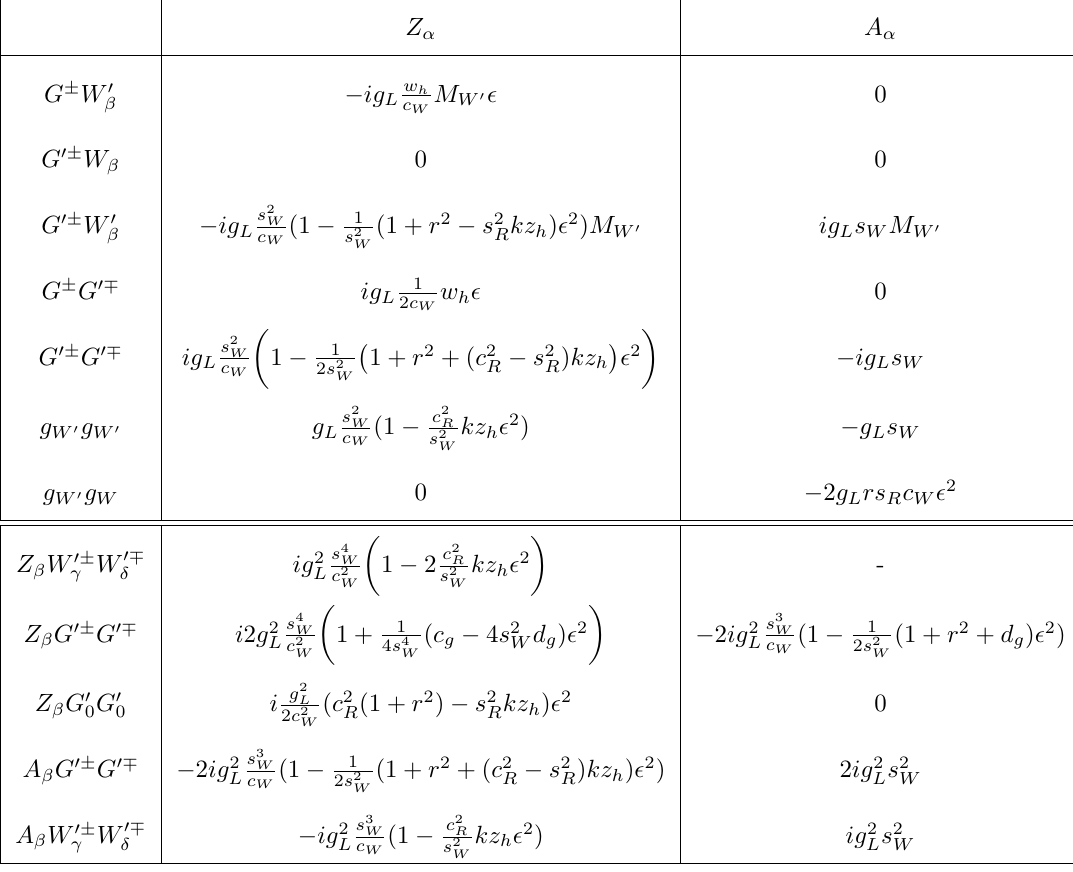
Table 16 . Triple and quadruple gauge couplings involving a Z boson and at least one unphysical Goldstone boson. c g = (1 (cid:0) 4 s 2